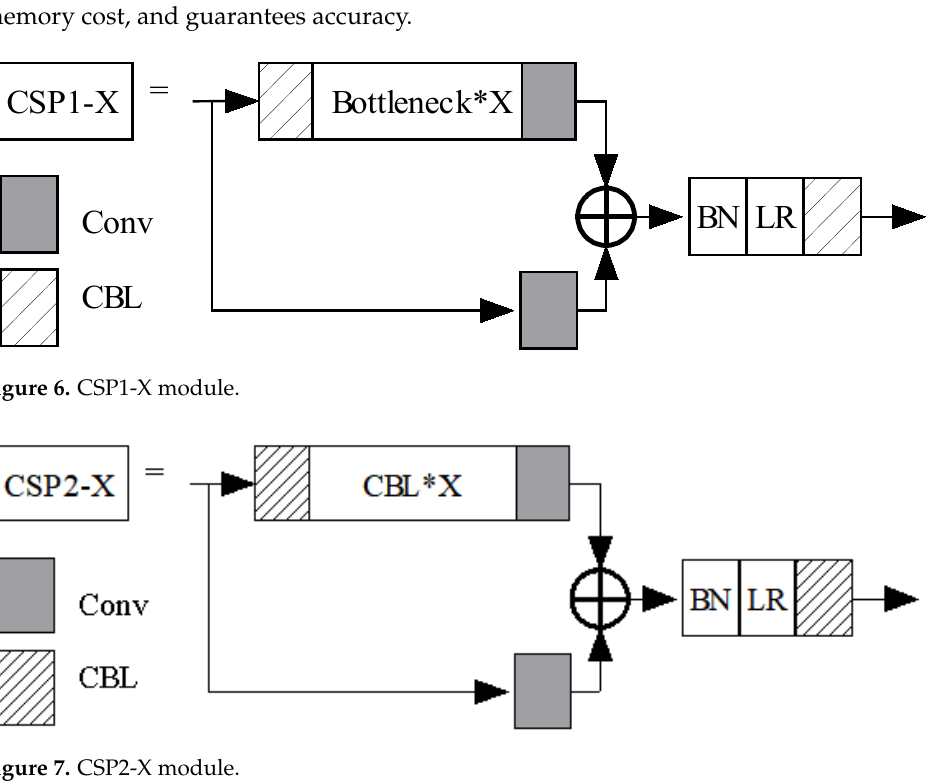
Figure 7. CSP2-X module. Figure 7. CSP2-X